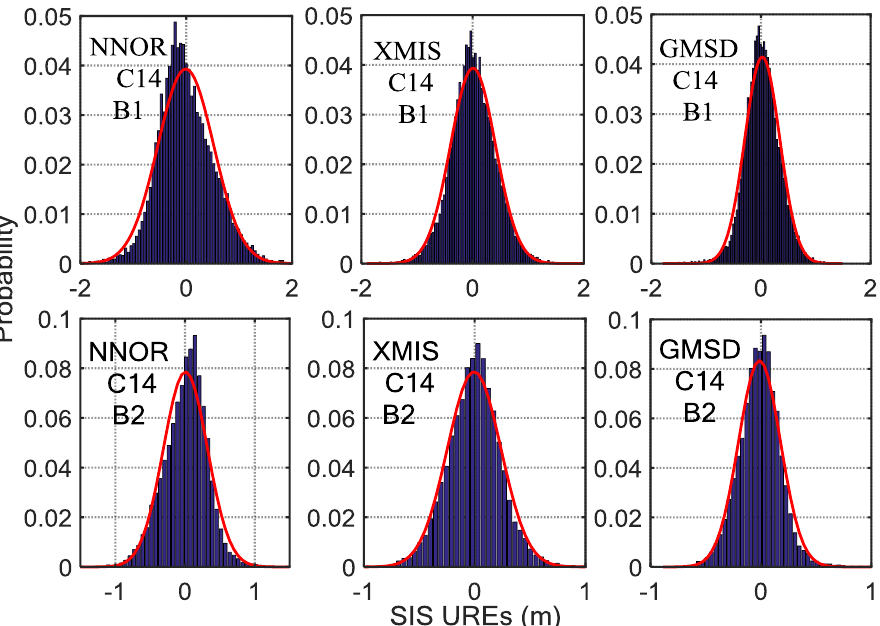
Figure 9. The histograms of C14 SIS UREs (m) after eliminating the trend term covering 14 experimental days, overlaid with empirical normal probability-density function (PDF) curves (in red). Six subplots, arranged in two rows and three columns, show the results for three tracking stations (left column, NNOR; middle column, XMIS; right column, GMSD) and two frequencies (upper row, B 1 band; bottom row, B 2 band).